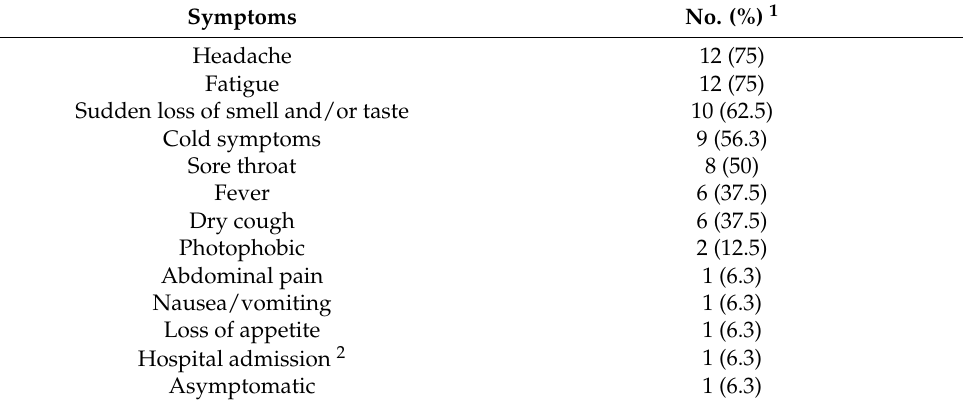
Table 3. Symptoms related to PCR-diagnosed SARS-CoV-2